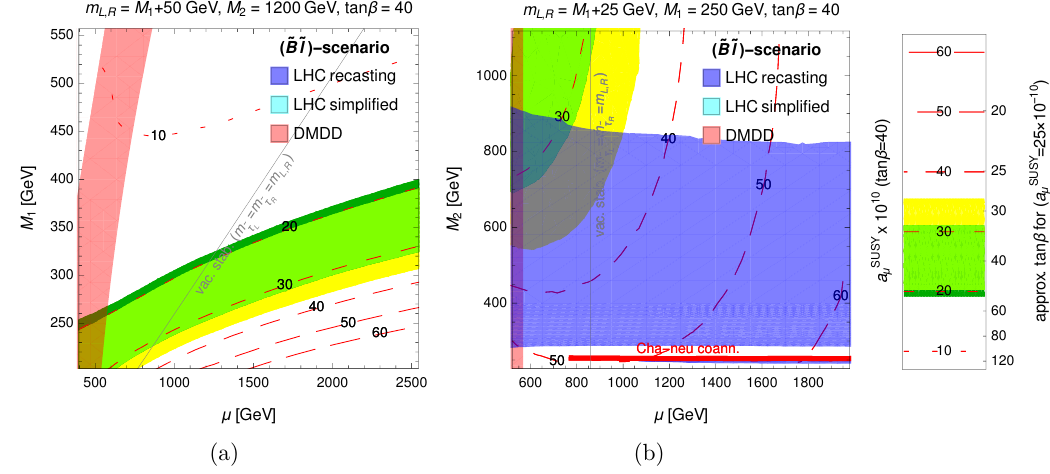
˜ ˜ Figure 16. ( B l ) -scenario with either M 2 = 1200 GeV fixed or M 1 = 250 GeV fixed. For the remaining parameter values see the plots. The red dashed contours correspond to values of a indicated in the legend on the right; the yellow/green coloured regions correspond to the 1 σ bands corresponding to the BNL deviation (1.6) and the new deviation including FNAL (1.7), and their overlap. For the tan β -reinterpretation see caption of figure 15. The (light) red shaded regions are excluded by dark matter direct detection if the LSP is assumed stable; the blue shaded region corresponds to the limits from the LHC recasting, see figure 20 and text for details. These plots do not contain regions excluded by the additional LHC limits implemented in a simplified way. The red thick solid line in the right plot corresponds to the parameter strip where chargino-neutralino coannihilation is possible; directly below this strip a tiny region is excluded by the LHC-constraint from compressed masses, ref. [482], but we verified that this does not exclude the chargino-neutralino coannihilation region. The gray thin line corresponds to the vacuum stability constraint of ref. [176]; it applies in case the left- and right-handed stau-masses are set equal to the smuon/selectron masses and excludes the points to the right, i.e. with larger µ